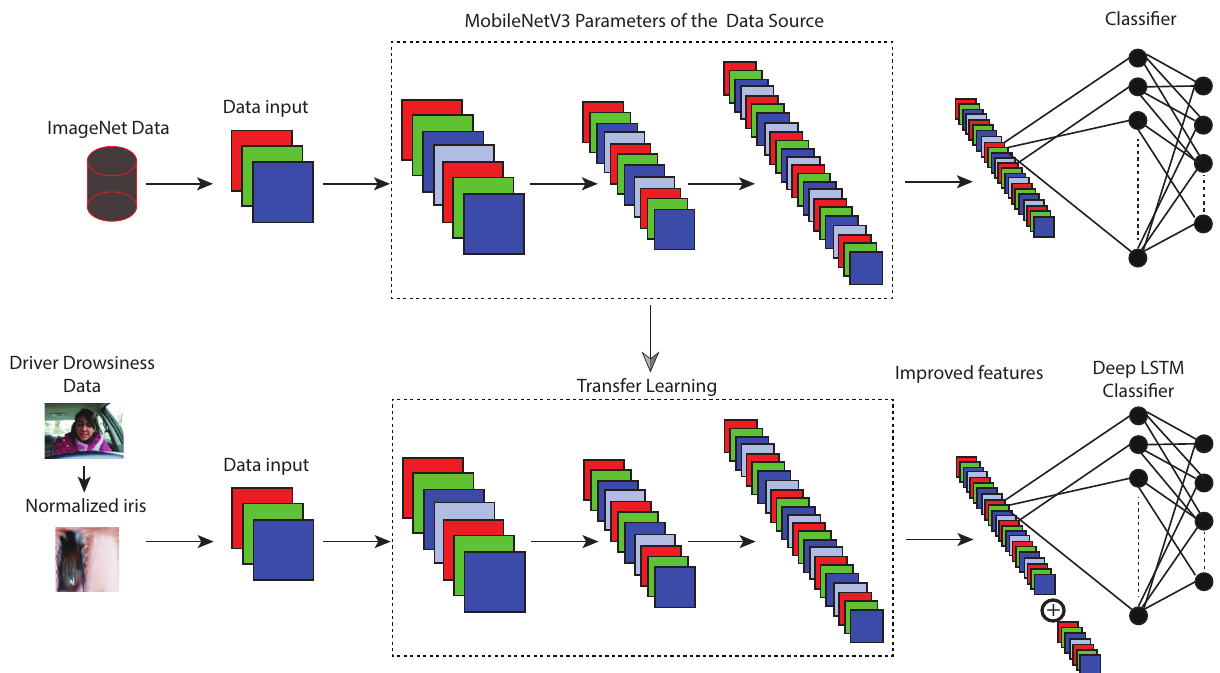
Figure 8. Proposed model transfer learning model for driver fatigue